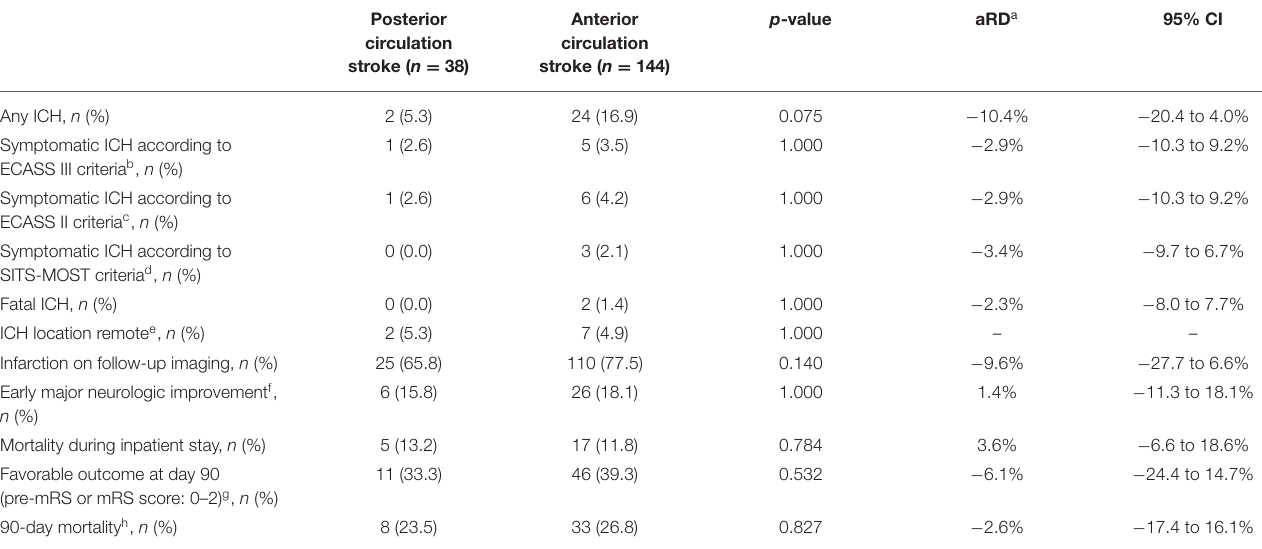
TABLE 3 | Outcomes in the clinico-radiological patient